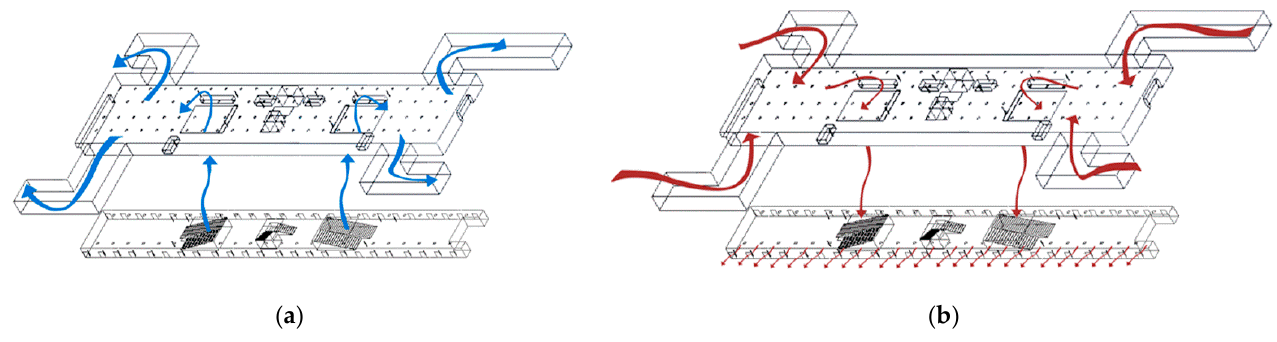
Figure 6. Two main airflow organization states: ( a ) PSDs closed; ( b ) PSDs opened.